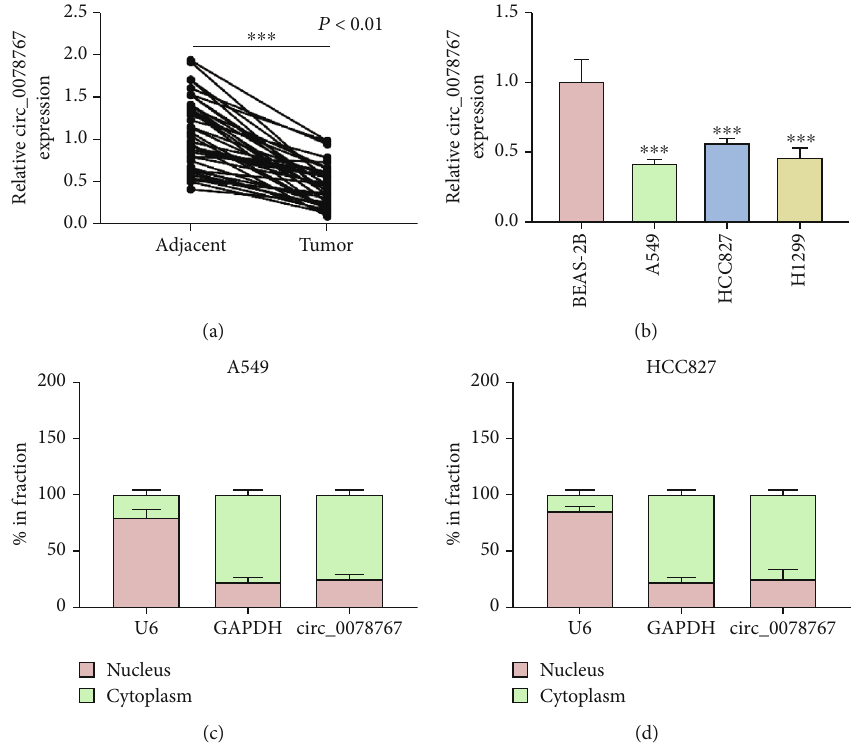
Figure 1: Circ_0078767 was upregulated in NSCLC tissues and cell lines. (a, b) The expression of circ_0078767 in NSCLC tissues ( n = 40 ) and cells was tested by qRT-PCR. (c, d) The distribution of circ_0078767 in nucleus or cytoplasm was determined by qPCR. ∗∗∗ P < 0 : 001